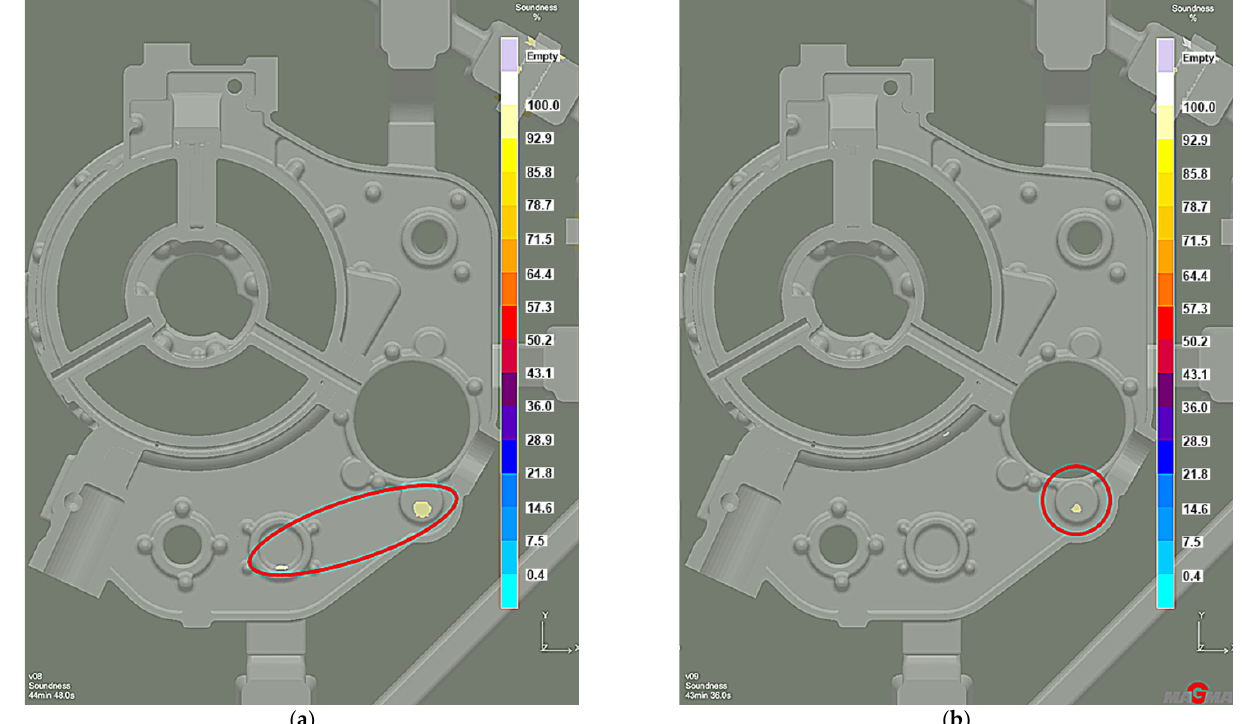
Figure 21. Stage 5 Soundness criterion: ( a ) 10 mm chiller thickness; ( b ) 15 mm chiller thickness.